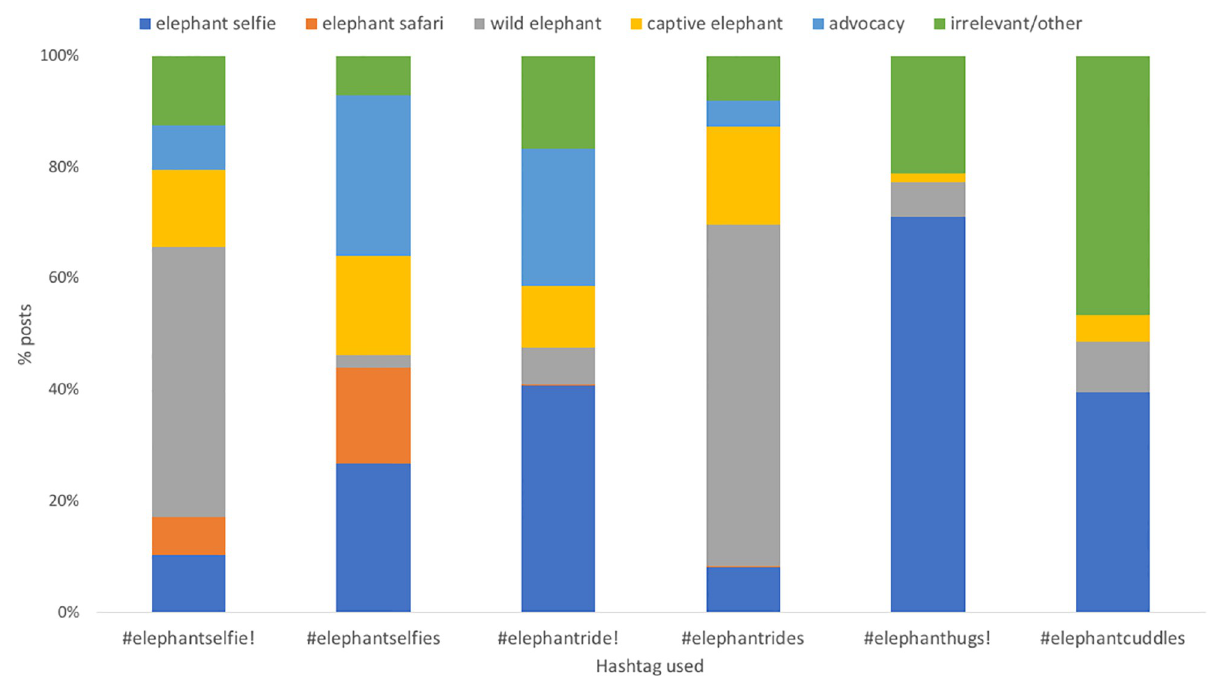
Fig 3. Types of post using each of six hashtags, where the first of each ‘pair’ (#elephantselfie-#elephantselfies, #elephantride-#elephantrides, #elephanthugs-#elephantcuddles) triggers Instagram’s warning (marked by an!) and the second does not. Relative proportions of post types were statistically significantly different between pairs of terms in all cases; n = 468, 225, 871, 487, 193, 268, respectively. Content categories defined in Methods and Table 1.